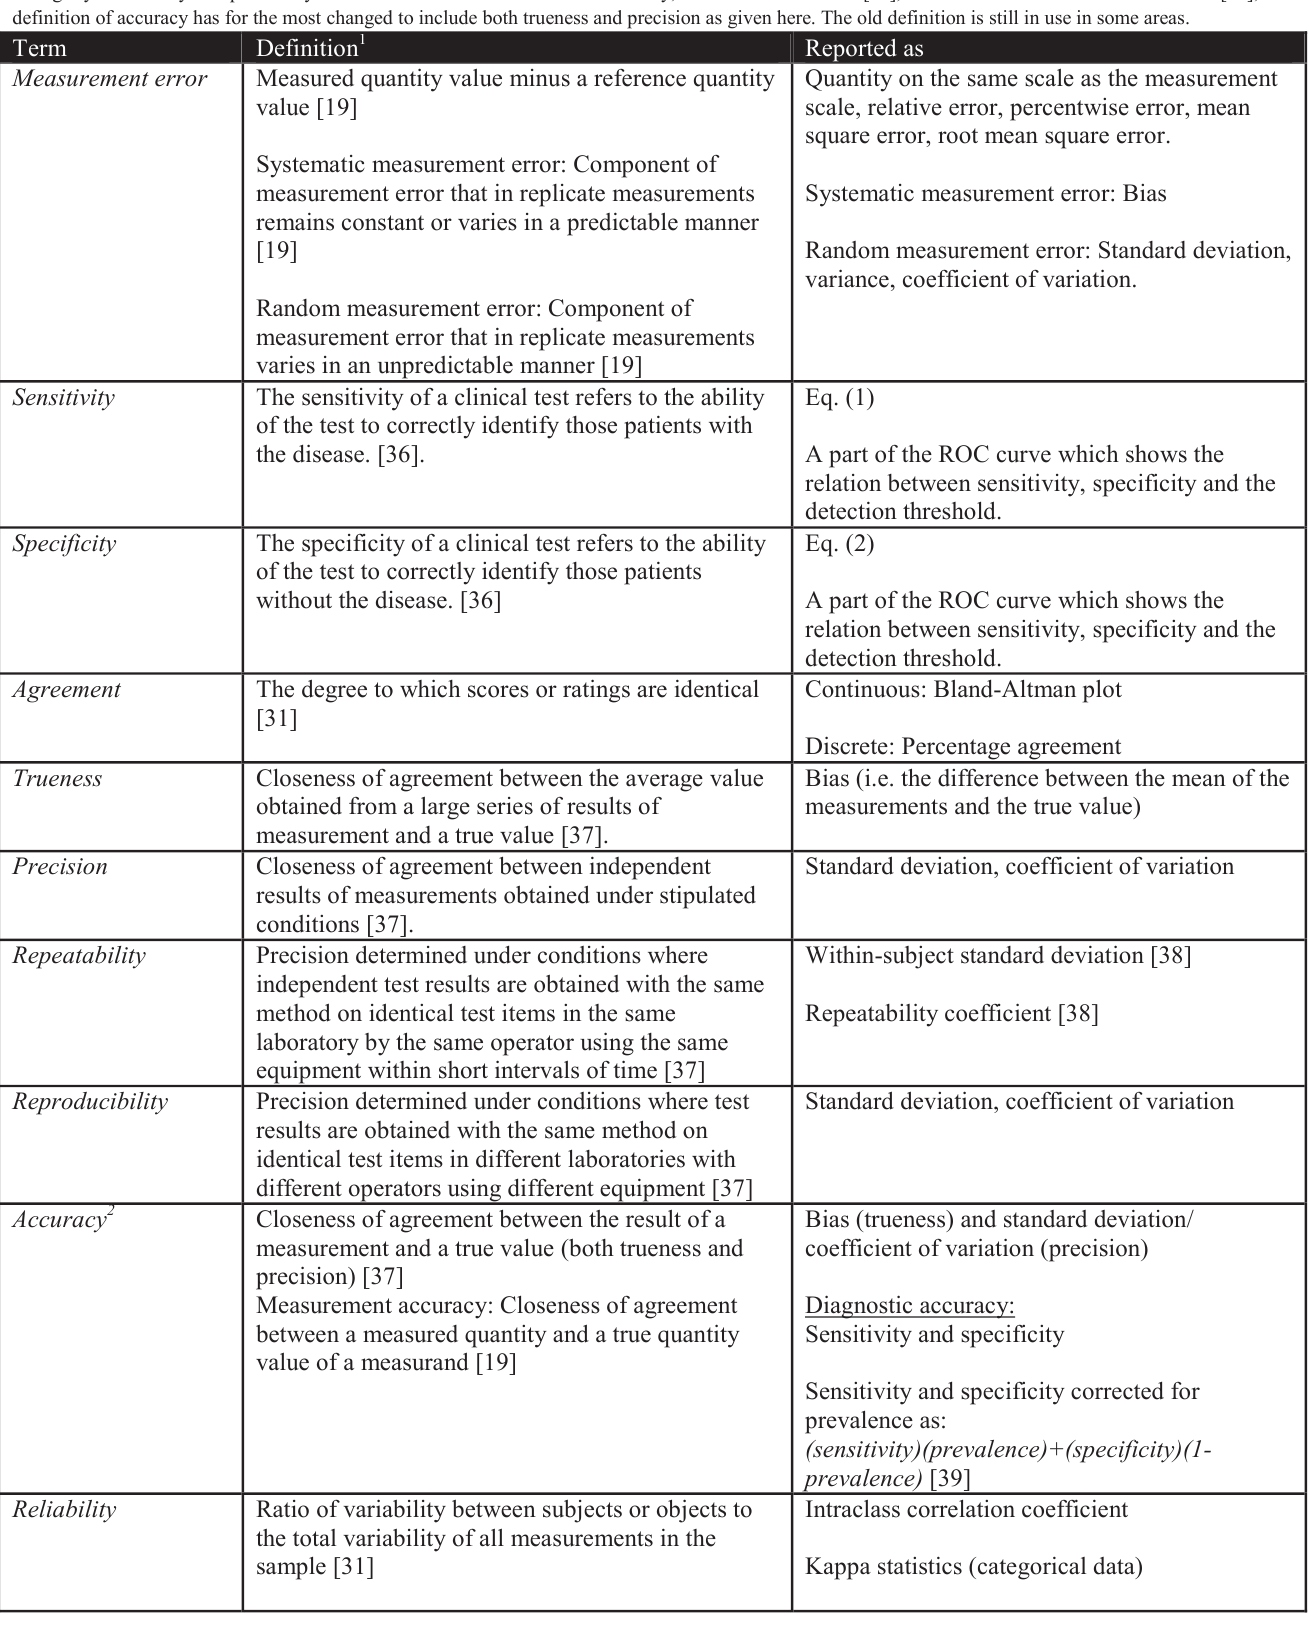
Table 1. List of important terms in the validation of new measurement technology along with the most usual and recommended ways of reporting. 1 There are numerous different definitions in the literature, which can be inconsistent and confusing. These definitions provide one version with the aim of reducing ambiguity. 2 Accuracy has previously been defined as the same as trueness only, but with ISO 5725 -1 [37] , and reflected in the JCGM 200:2012 [19], the definition of accuracy has for the most changed to include both trueness and precision as given here. The old definition is still in use in some